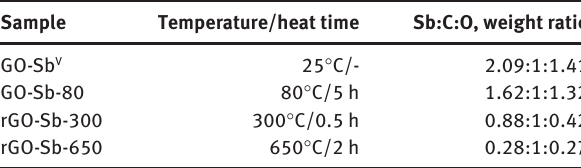
Table 1: EDX elemental analysis of anode material.